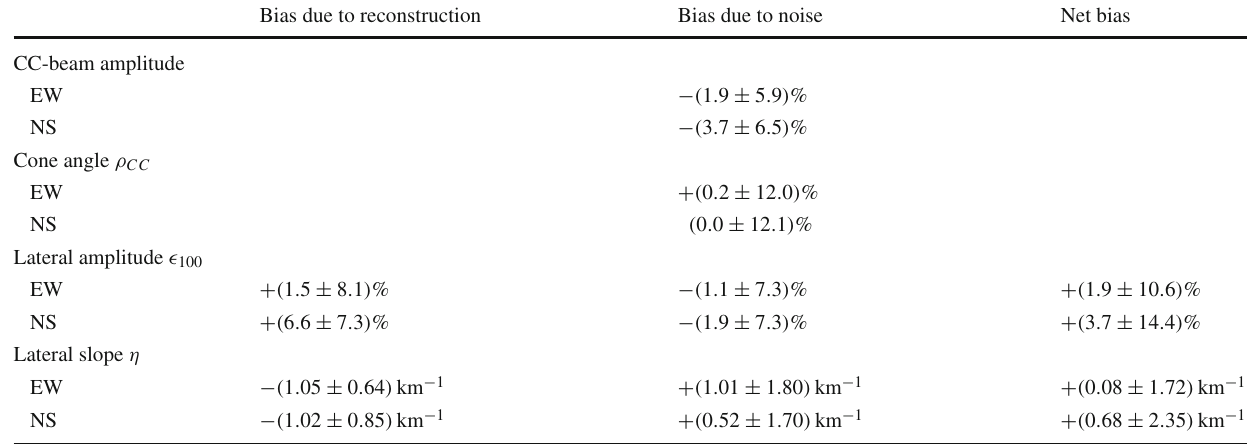
Table 2 Average bias due to noise determined by comparing the end- LOPES are stated: (1 − true/reconstructed) and (true − reconstructed), to-end simulations with and without noise for the east–west (EW) and respectively. Such a bias cannot be determined for parameters of the north–south(NS)polarizationcomponents,respectively.Thestatedval- cross-correlation beamforming, since it implicitly includes the recon- ues were calculated as (1 − without noise/with noise) for values given struction simplifications and, thus, no ’true’ values without bias are in % and as (without noise–with noise) for the slope parameter η . For available from the CoREAS simulations. The ± indicates the standard the parameters of the lateral distribution, (cid:4) 100 and η , also the biases deviation, which for the bias due to noise can be interpreted as average statistical uncertainty of the corresponding quantity due to noise due to the simplified reconstruction method of the electric field used by Bias due to reconstruction Bias due to noise Net bias